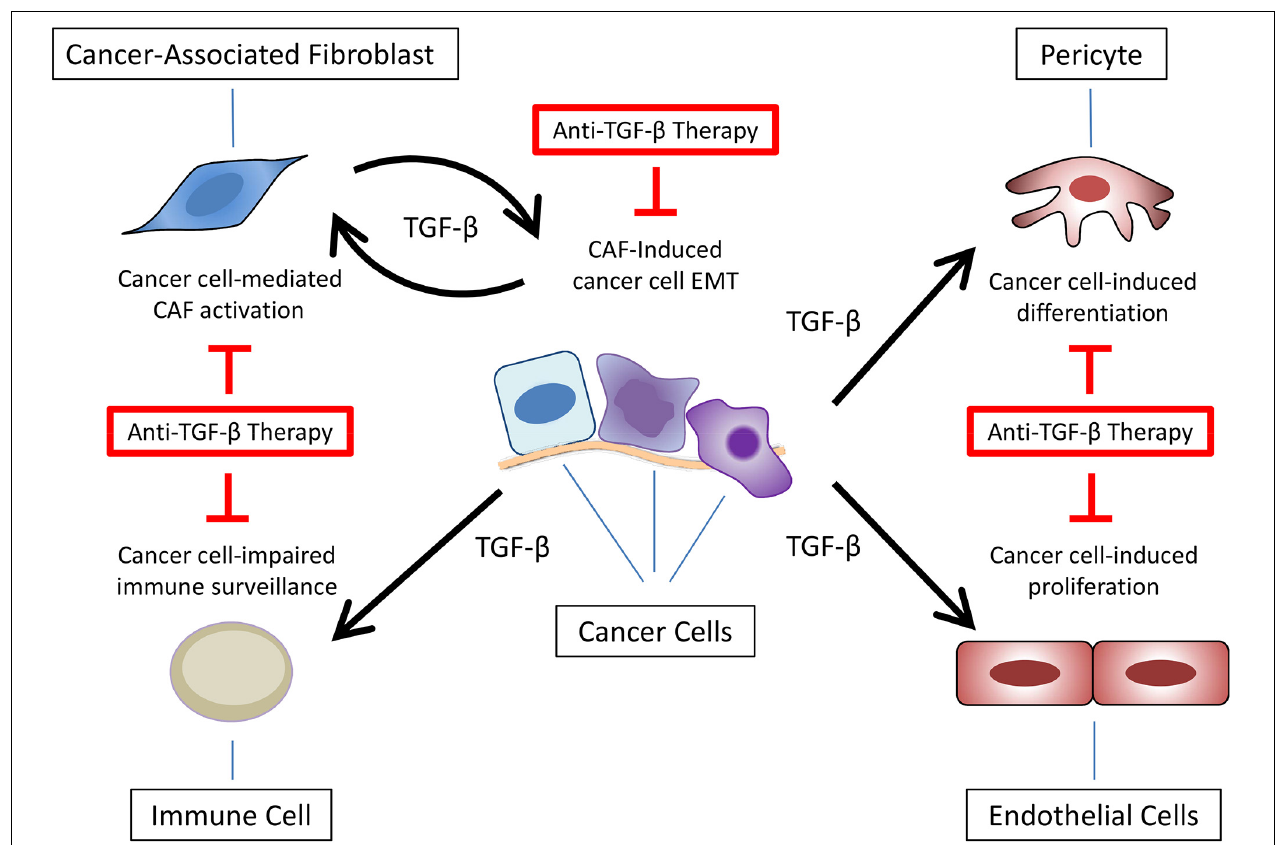
FIGURE 4 | Anti-TGF- β therapies targeting multiple components of tumor microenvironment. Besides epithelial-mesenchymal transition (EMT) in cancer cells, TGF- β secretion at the tumor microenvironment promotes cancer-associated fibroblast (CAF) activation, impaired immune surveillance, pericytes differentiation, and endothelial cell